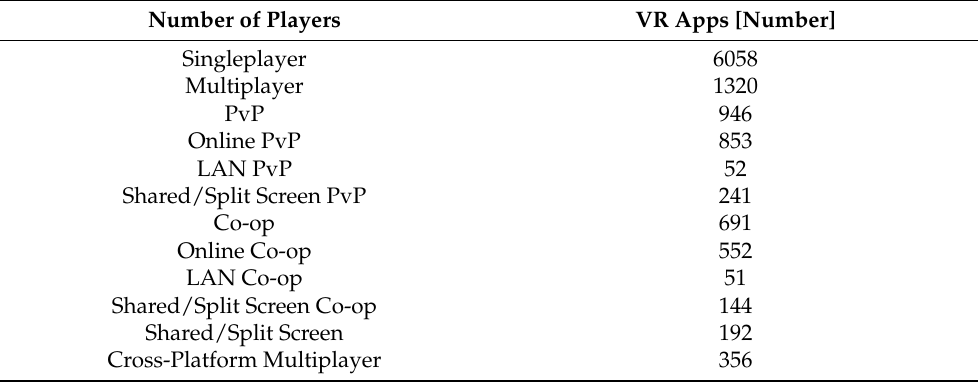
Table 3. The number of VR applications based on the headset [stated on 6 July 2022]. Headset VR Apps [Number] Valve Index 5416 HTC Vive 5784 Oculus Rift 4744 Windows Mixed Reality